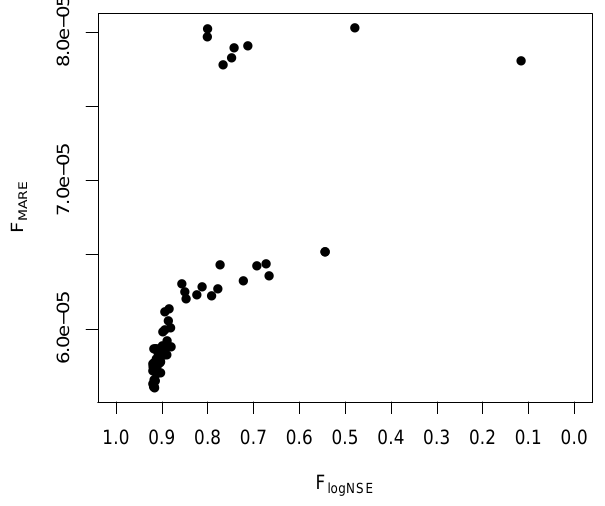
Fig. 3. F logNSE versus F MARE for the 79 FUSE models after cali- bration with SCE (Shuffled Complex Evolution algorithm).